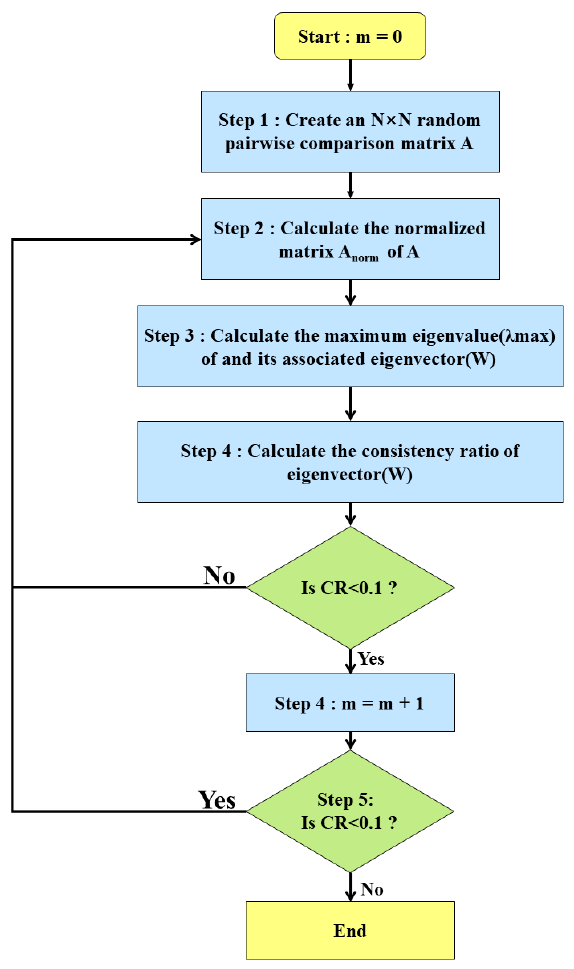
Figure 4. Flowchart for calculating the weights of the evaluation criteria by the Monte Carlo analytical hierarchy process.